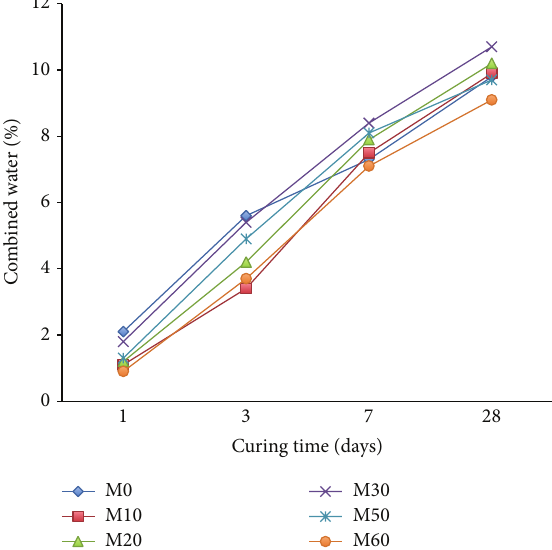
Figure 9: The effect of FA on combined water content of mortar mixes without